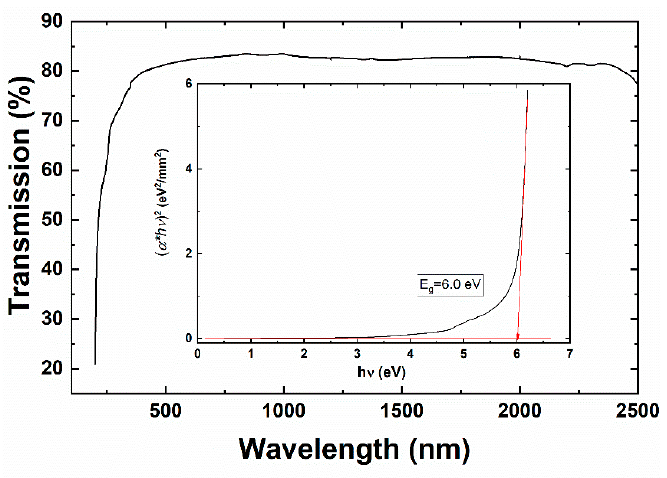
Figure 10. Optical transparency window of the LYSB crystal. Tauc’s plot is shown in the figure inset. (Adapted with permission from ref. [13], copyright 2019 American Chemical Society).